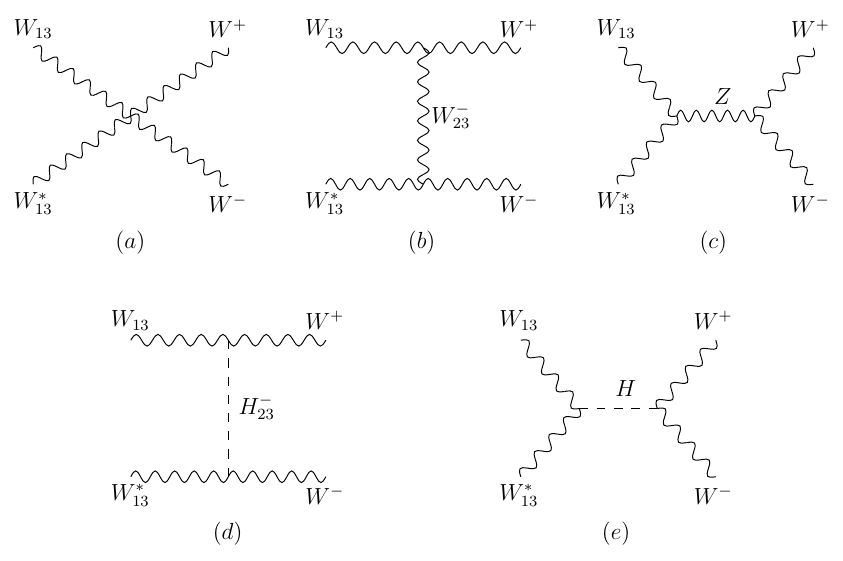
+ W (cid:0) , where H (cid:0) 23 is the physical 13 W (cid:3) 13 ! W and ’ (cid:0) , while the remaining combination orthogonal 32 23 . For a reference, the (cid:12)elds Z , H , and H (cid:0) are 23 23